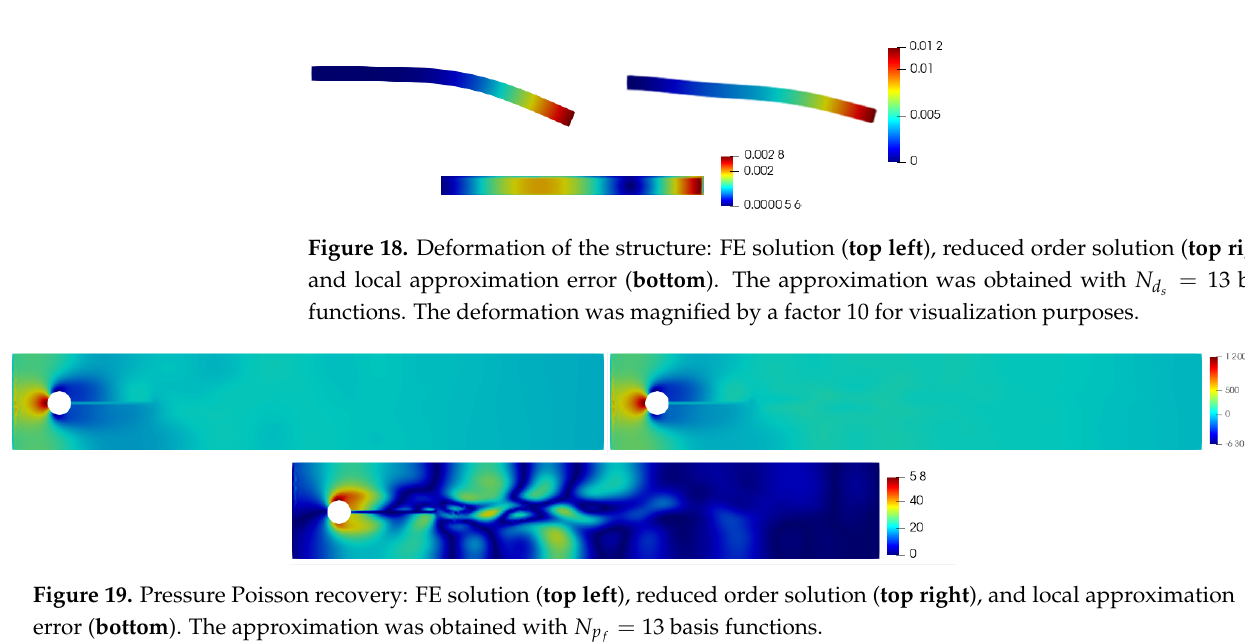
= 13 basis functions. f